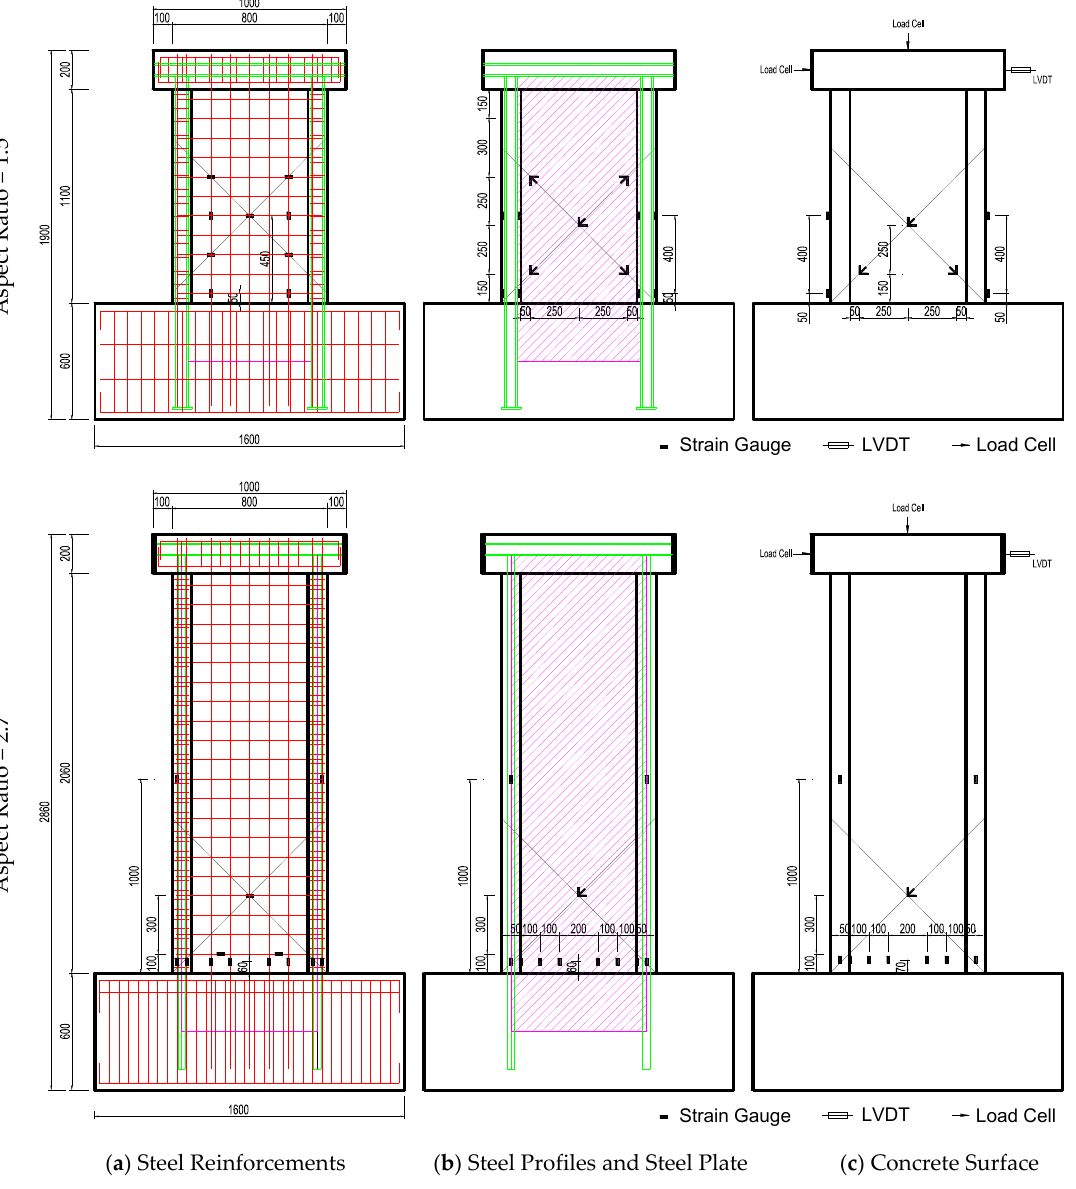
Figure 4. Instrumentation Layout of Test Specimens ( a ) Strain Gauges on Steel Reinforcements; ( b ) Strain Gauges on I-shaped Steel Profiles and Steel Plate; and. ( c ) Strain Gauges, Linear Variable Differential Transformer (LVDT) & Load Cells on Concrete.